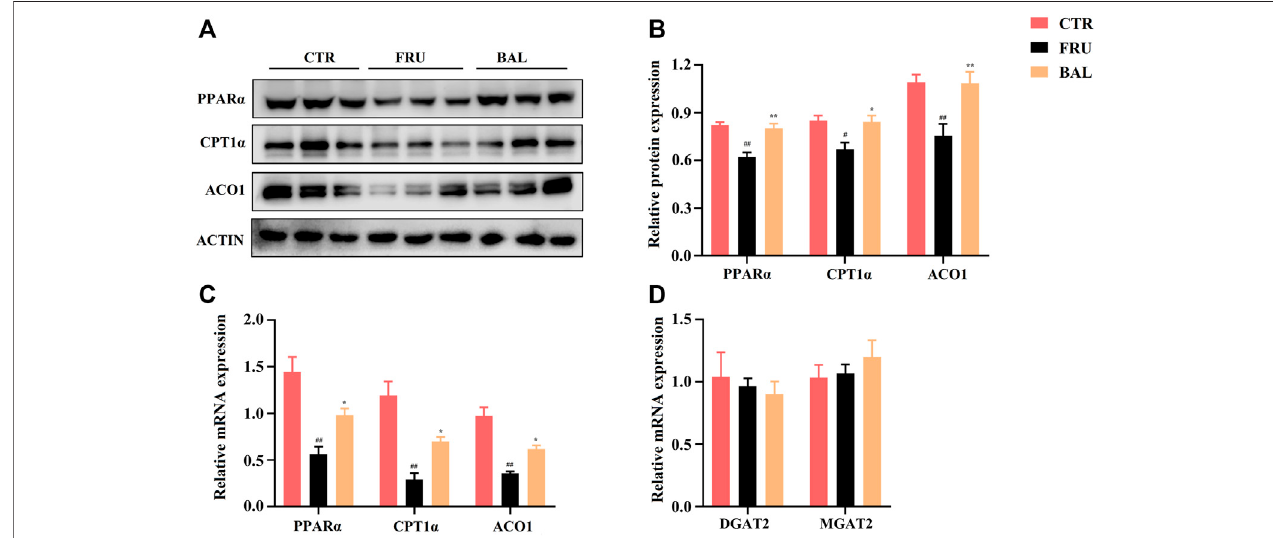
FIGURE 8| Effects ofBAL treatment on PPAR α elicited fatty acidsoxidation pathway and the key enzymes ’ (DGAT2 and MGAT2) levels in triglyceride synthesis of fructose-fed rat liver. (A,B) Protein expressions of ACO1, CPT1 α and PPAR α by western-blot analysis. (C) FAO associated genes expressions of PPAR α , CPT1 α and ACO1. (D) mRNA levels ofDGAT2 and MGAT2. Datawere represented asMean ±SEM ( n =6/group), ## p < 0.01 , # p < 0.05 , compared withCTR; **p < 0.01 , *p < 0.05 , compared to